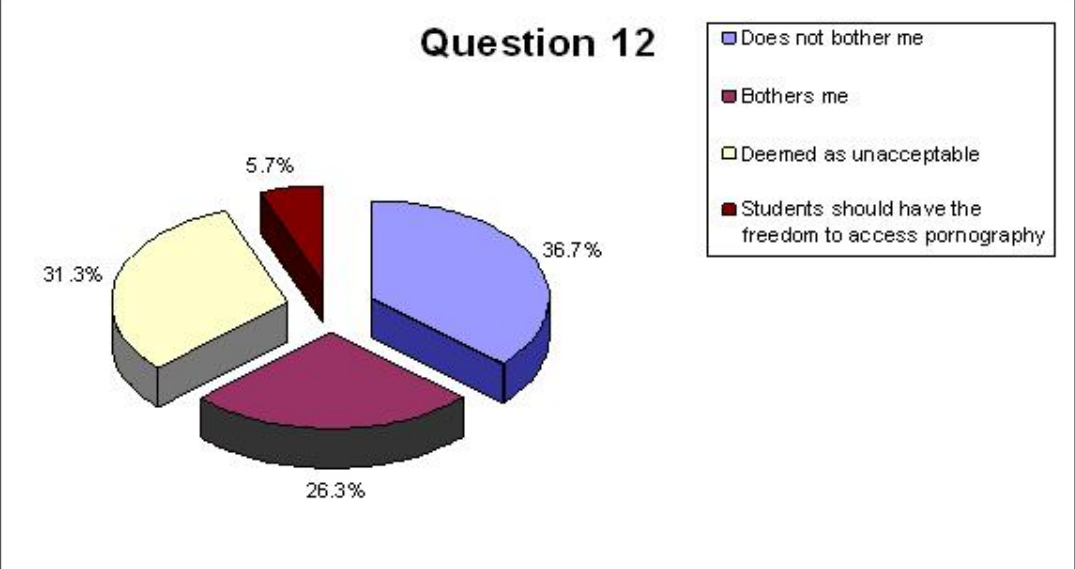
Figure 6 Results for Question 12: How tolerant are you towards exposure to unsolicited pornography while using the computer facilities provided by the University of